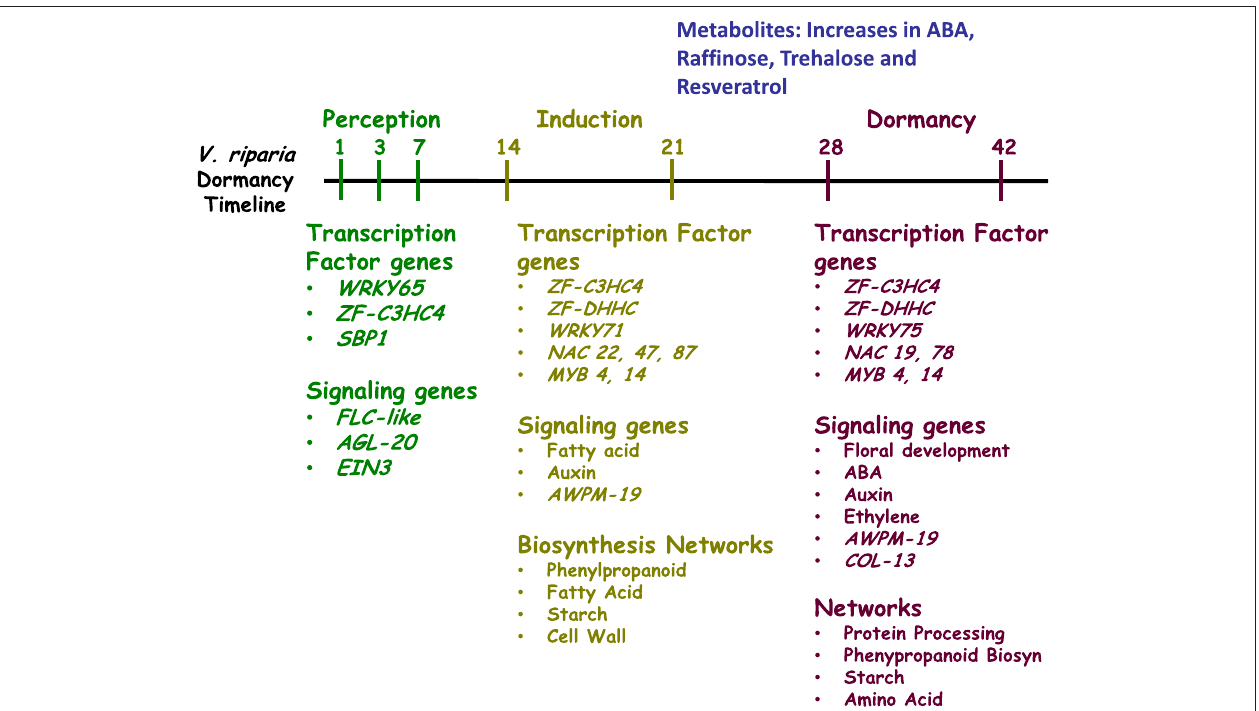
FIGURE 6 | Summary of the differentially expressed transcription factor and signaling genes and the enriched molecular networks during perception, induction or dormancy phase. Perception phase (D01, D03, D07) is in green; induction phase (D14, D21) is in olive and dormancy phase (D28, D42) is in purple. Metabolites differentially abundant during dormancy are in